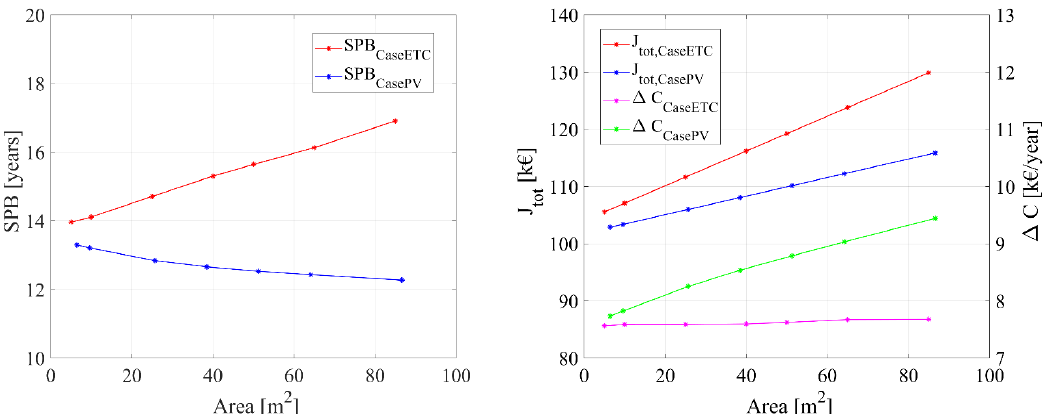
Figure 14. Parametric analysis: SPB ( left ) and capital and operative cost ( right ).